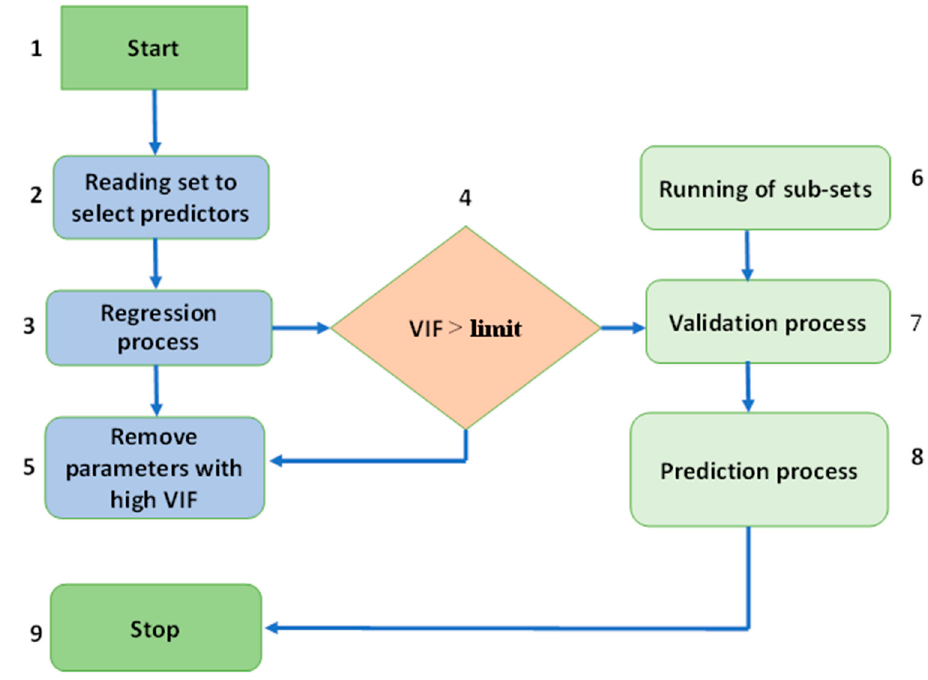
Figure 3. Multilayer perceptron model execution process [63].